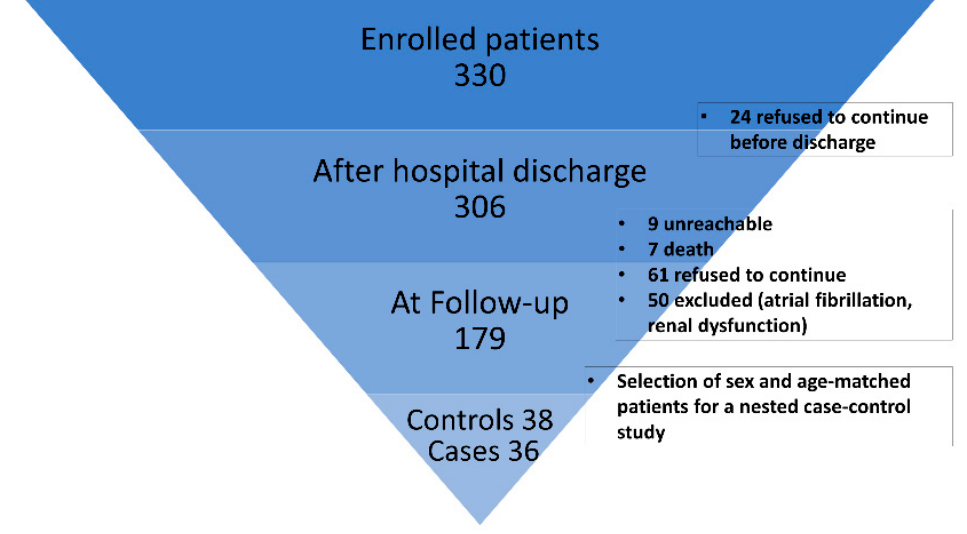
Figure 1. Study enrollment flow chart.